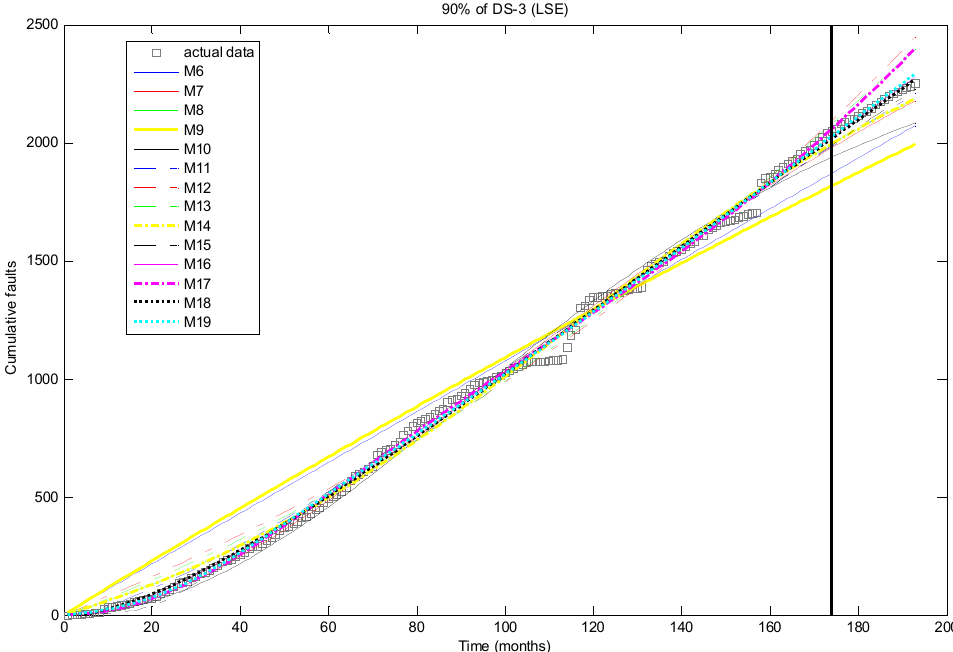
Figure 7. Comparisons of the prediction results of M6 to M19 for DS-3.